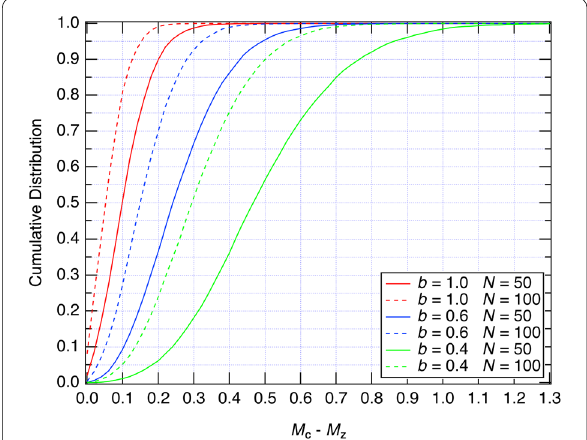
Fig. 3 Cumulative frequency distribution of M c expected under the GR law when the lower limit of M z is fixed. For each value of b and N , M -series data (the number of data points is N ) are generated 10,000 times using random numbers; the MAXC method with bootstrap resampling (1,000 times) is used to estimate of M